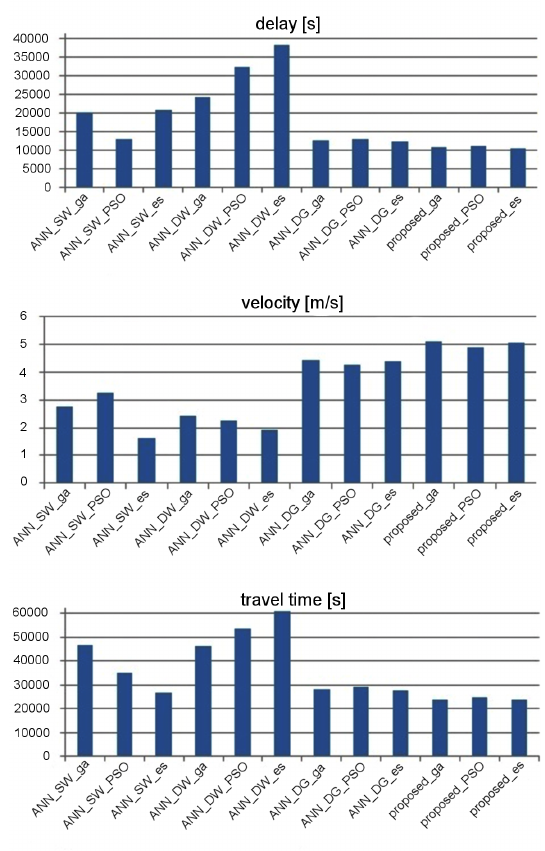
Figure 14. Effectiveness of traffic control for the considered ANNs in signalized arterial road.